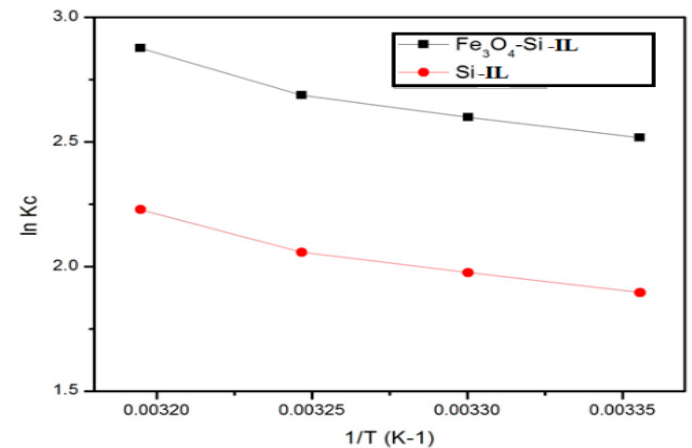
Figure 12. Plot of lnK c (the equilibrium concentration constant) versus 1/ T for Si-IL and Fe 3 O 4 -Si-IL at the temperature range of 303–333 K.